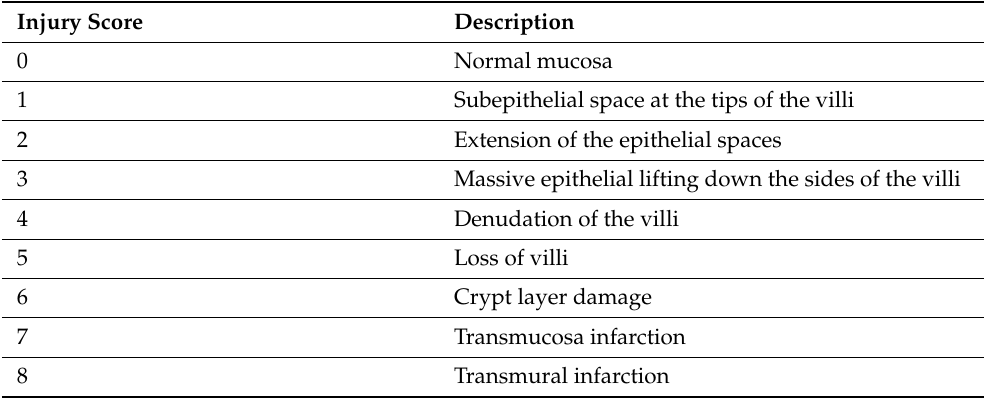
Table 1. Intestinal Histology Injury Scores (HIS) as described by Park et al. [8]. Injury Score